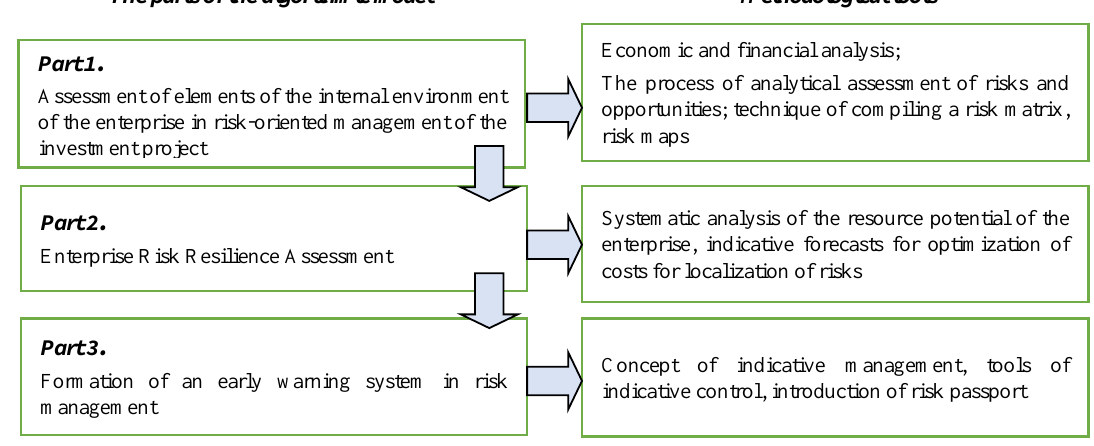
Figure 4. Algorithmic model for building a risk management system for investment projects of small